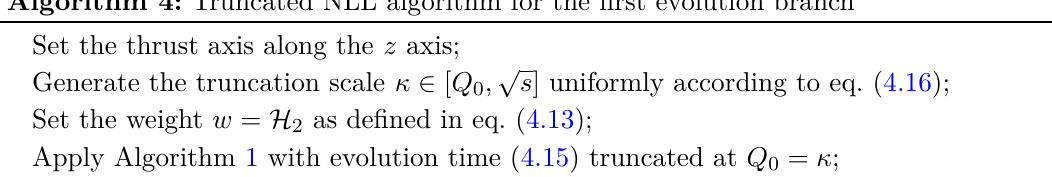
Algorithm 4: Truncated NLL algorithm for the first evolution